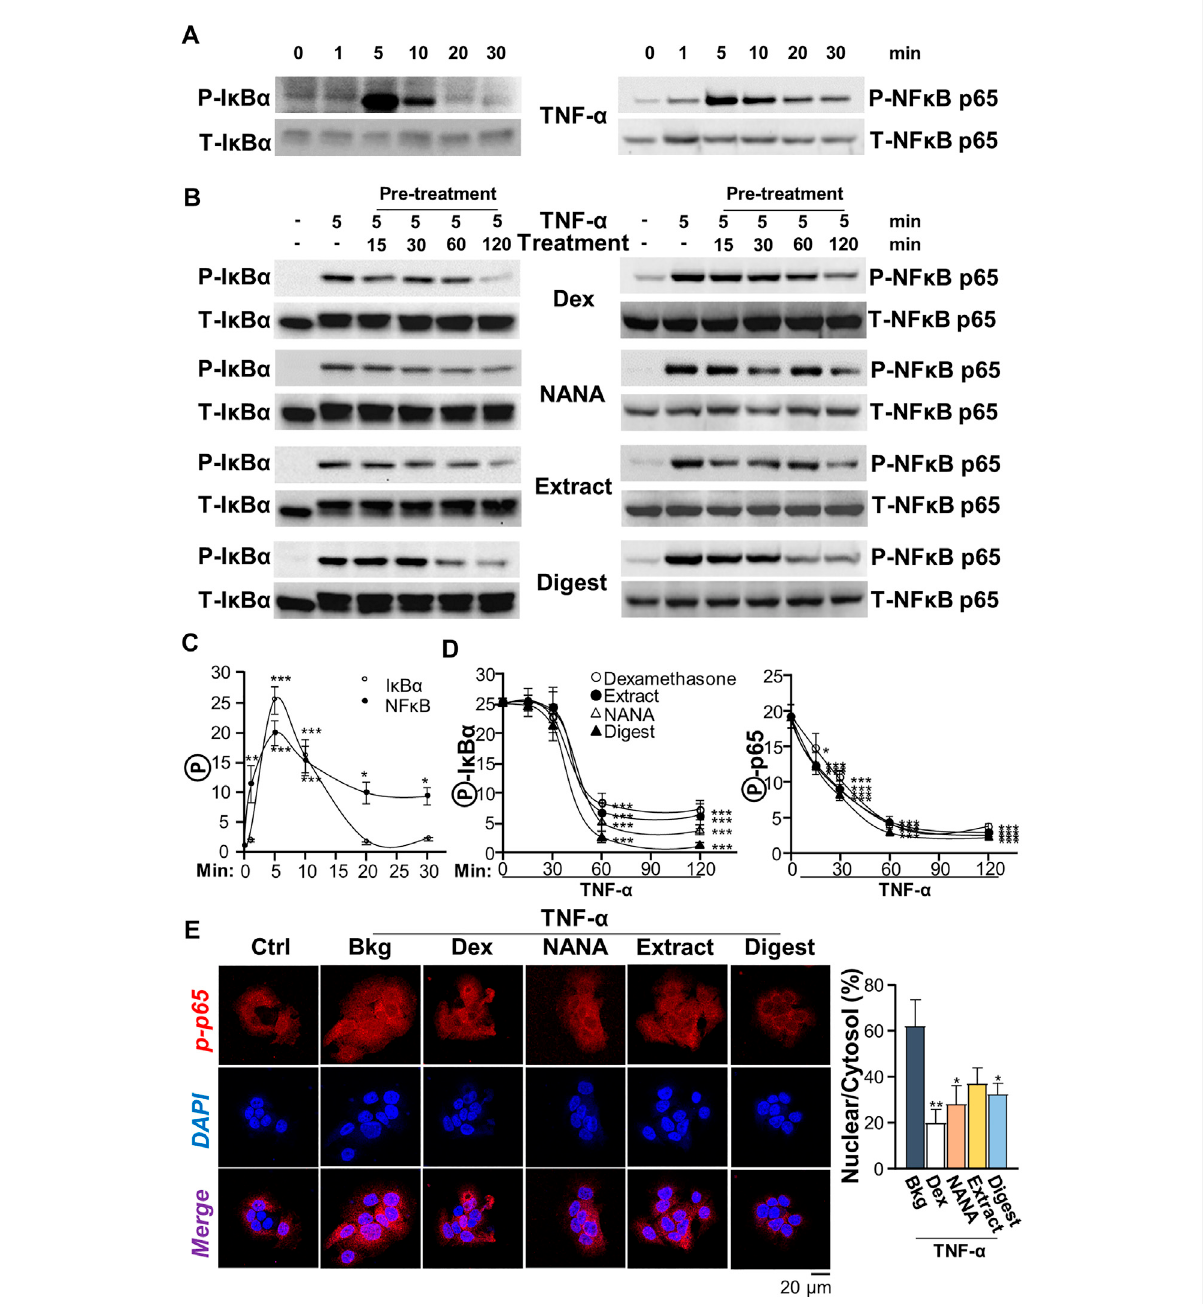
FIGURE 4 EBNinhibitsTNF- α -inducedphosphorylations ofI κ -B α and NF- κ Bp65. (A) After16-h serum starvation, cultured keratinocyteswereinduced by TNF- α (20 ng/mL) at a period of 0 – 30 min, as indicated. Total I κ -B α and NF- κ B p65 (T-I κ -B α , 38 kDa and T-NF- κ B p65, 65 kDa) and phosphorylated I κ -B α and NF- κ B p65 (P-I κ -B α , 38 kDa and P-NF- κ B p65, 65 kDa) were evaluated by western blot assays. (B) After 16-h serum starvation, EBN pre- treatment in cultured keratinocytes were tested. Pre-incubation at 15, 30, 60 and 120 min was performed. Dexamethasone (a positive control, 10 nM), NANA (1 mM), EBN extract and digest (both at 100 μ g/mL) were applied, and then cells were incubated with TNF- α for 5 min afterwards. (C) The quanti fi cations of P-I κ -B α /T-I κ -B α and P-NF- κ B p65/T-NF- κ B p65 expression levels after different time of TNF- α treatment are shown. (D) The quanti fi cationsofP-I κ -B α /T-I κ -B α andP-NF- κ Bp65/T-NF- κ Bp65expressionlevelsfrompre-treatmentsof (B) areshown. (E) Cytosolicandnuclear expressions of phosphorylated NF- κ B p65 protein in keratinocytes after 4-h pre-treatment of NANA (1 mM), EBN extract and EBN digest (both at 100 μ g/mL) and 5 min TNF- α stimulation are shown, in representative confocal images (left panel). The quanti fi cations of P-NF- κ B p65 nuclear to cytosol intensity percentage under different treatments are shown (right panel). Values are expressed as the fold change to normalized basal activity setat 1,in mean ± SEM, n = 3. Statistically signi fi cant results are marked with * p < 0.05, ** p < 0.01 and *** p < 0.001 against theTNF- α -treated